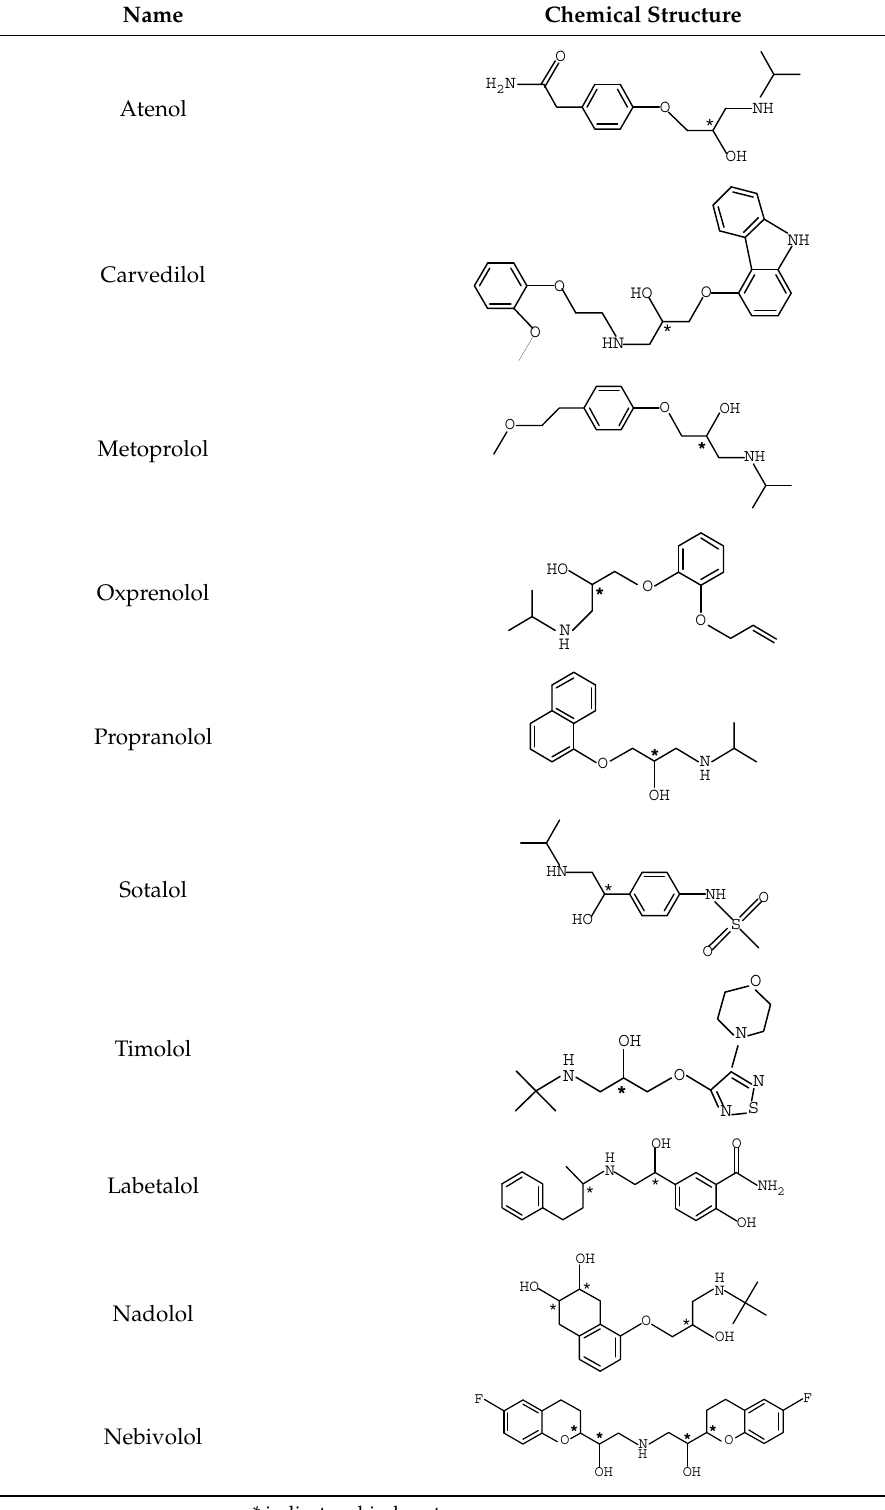
Table 1. Chemical structures of typical β -blockers with different chiral centers.